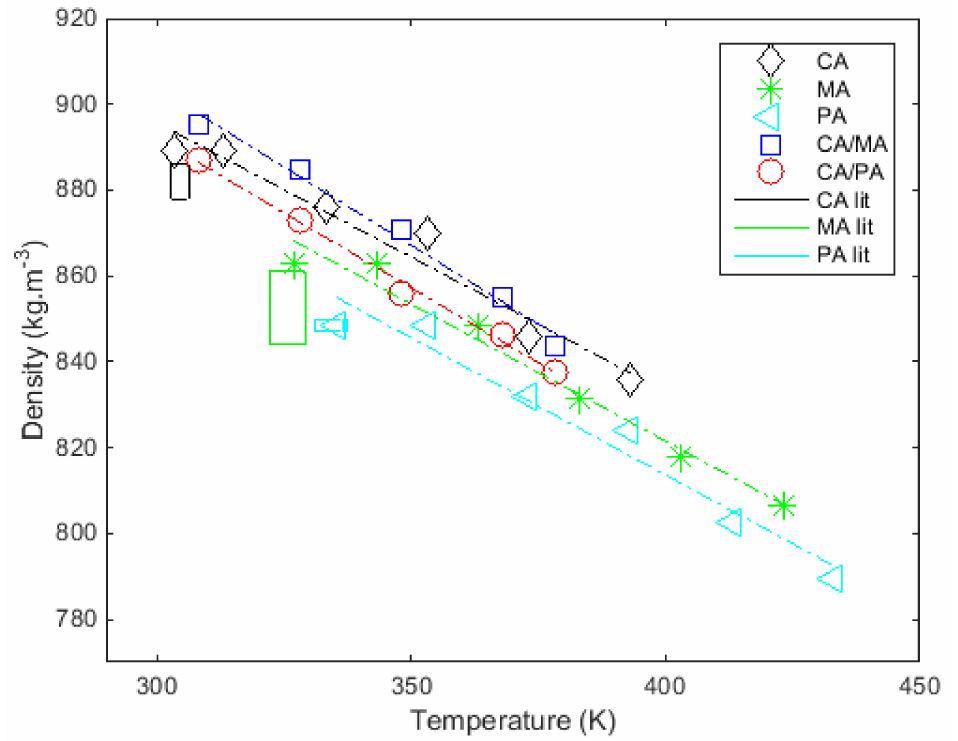
Figure 2. Measurements of the density in the liquid state as a function of temperature and comparison with results from the literature at melting temperature